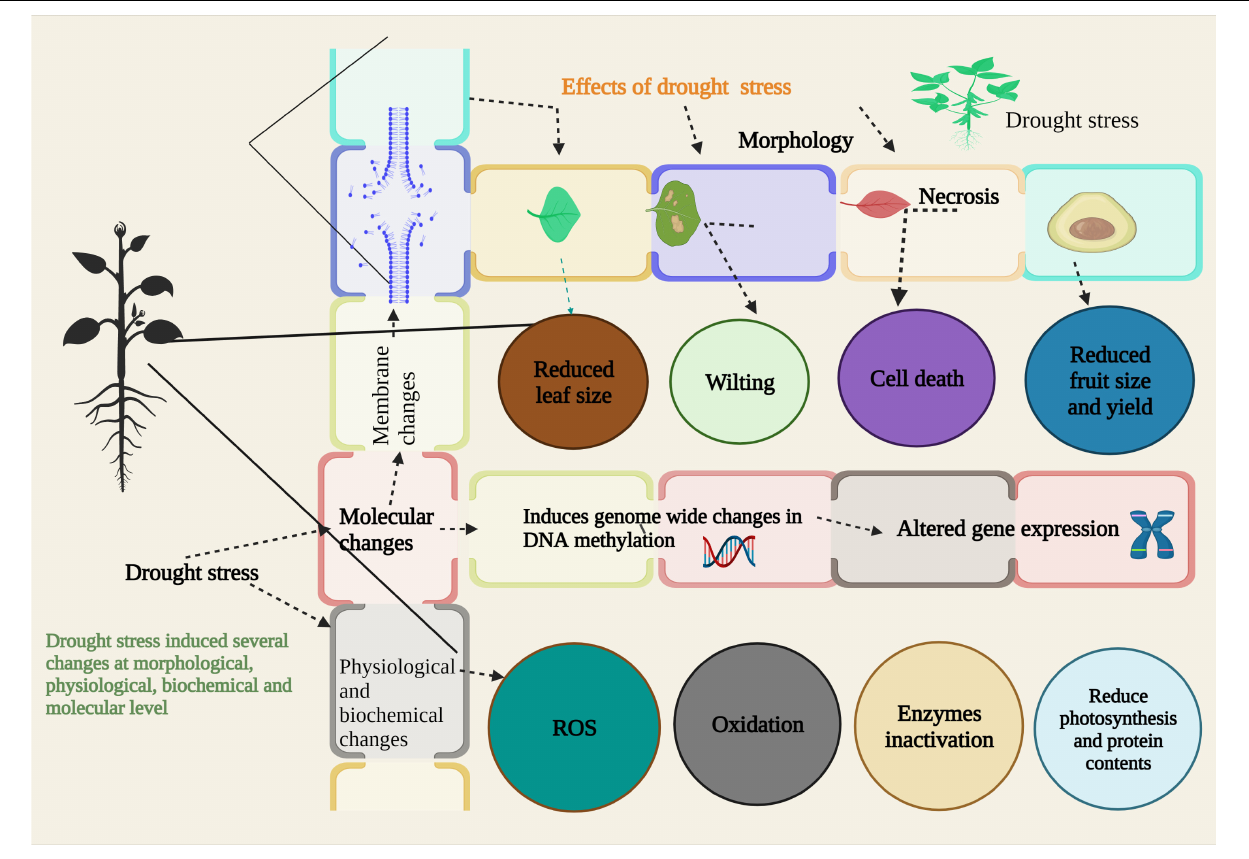
FIGURE 2 | Effects of drought stress (DS) on various stages of plant growth and development. At morphological level, DS induces several changes in plant like, chlorosis, necrosis, wilting, reduced leaf size, cell death, and yield reduction. At physiological and biochemical level, DS also causes oxidation by production of reactive oxygen species (ROS), inactivation of enzymatic action, and reduced photosynthesis and protein contents. DS also brings certain alterations at molecular level like, changes in DNA methylation and altered gene